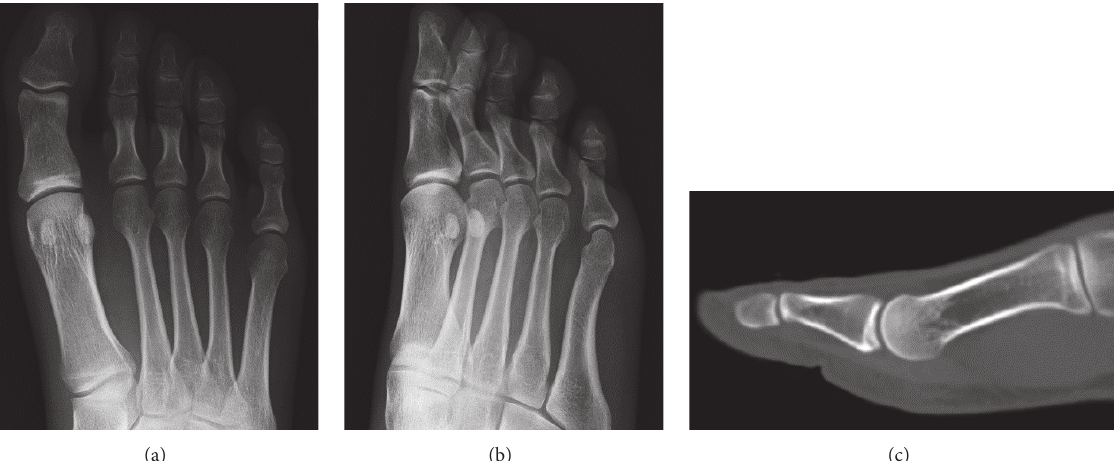
Figure 1: Plain radiographs and computed tomography showed no significant abnormality. (a) Anteroposterior radiograph of the foot. (b) Oblique radiograph of the foot. (c) Sagittal plane of the great toe in computed tomography.